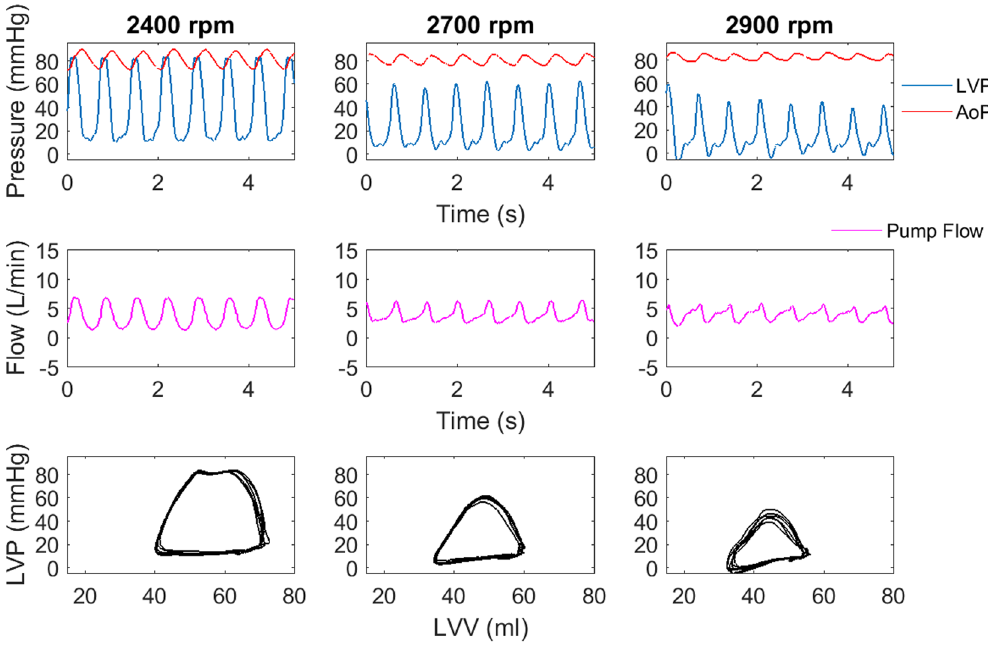
Figure 1. Typical time courses of pressure and flows at three different pumps speeds (upper and mid panel) at a cardiac output of 3.4 L/min. In the lower panel the respective PV loops are depicted.